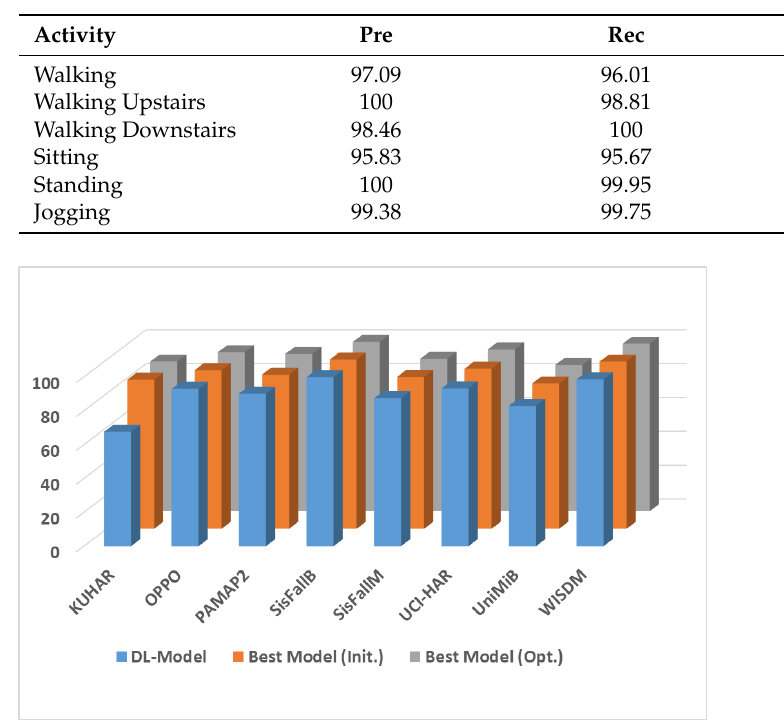
Table 12. Classification rates (%) of the best model of the WISDM dataset using RF.